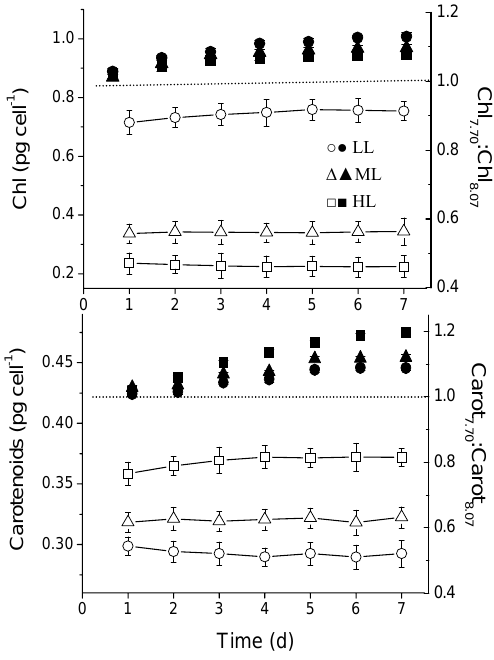
Figure 2. Contents of chlorophyll (a) and carotenoids (b) of P. glo- bosa cells grown at pH 8.07 (open symbols) and the ratios (solid symbols) of the pigments at pH 7.70 to those at pH 8.07 under dif- ferent irradiance levels (LL, 25; ML, 200; HL, 800µmol photons m − 2 s − 1 ). The data represent the means ± SD ( n = 3, triplicate cul-